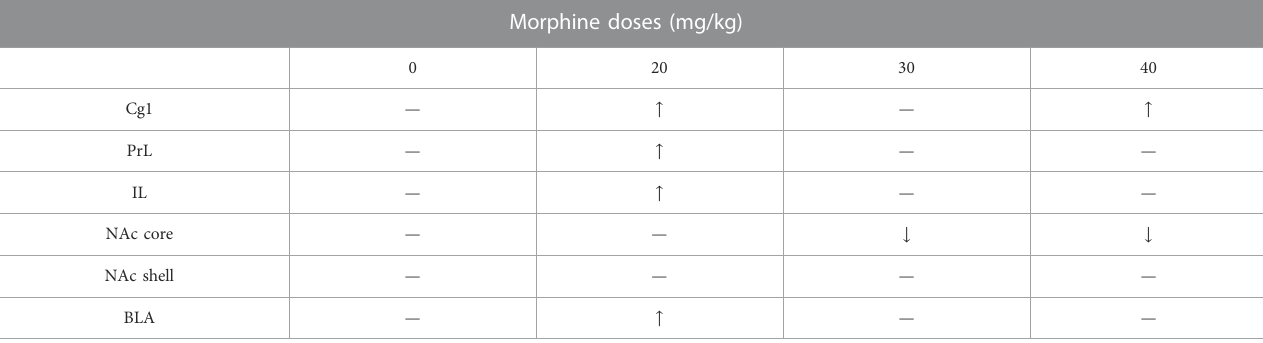
TABLE 2 Summary of c-Fos (%) in speci fi c brain areas for various doses of morphine injections after morphine-induced conditioned place preference